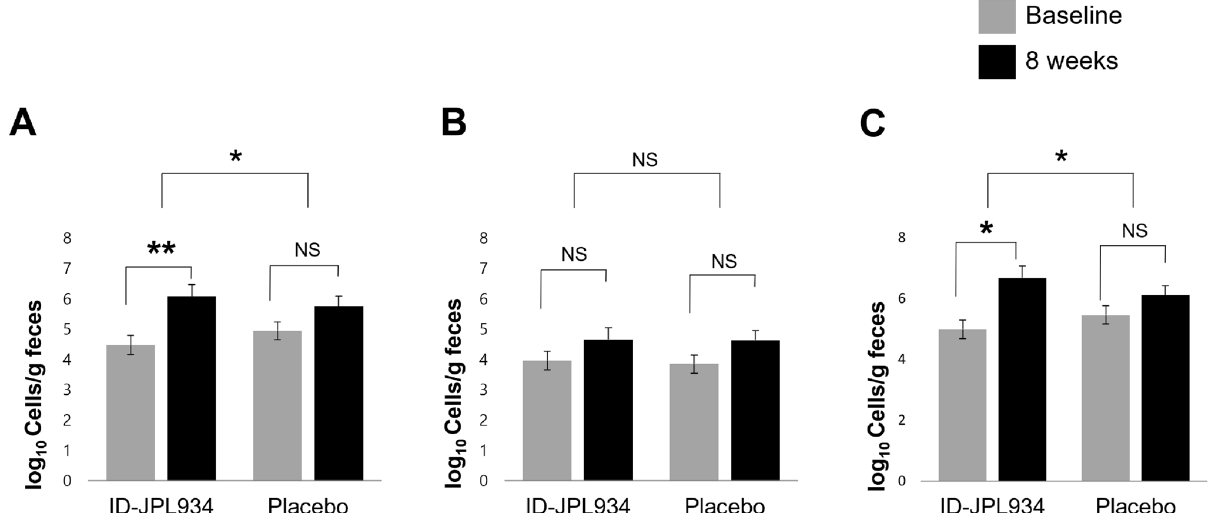
Figure 5. Quantitative changes in fecal probiotic levels at baseline and at week 8. ( A ) Lactobacillus johnsonii IDCC9203, ( B ) Lactobacillus plantarum IDCC3501, ( C ) Bifidobacterium lactis IDCC4301; P -values within the group were calculated using paired t-test; P -values between the 2 groups were calculated using repeated- measures analysis of variance. Means and standardized error are shown. * P < 0.05, ** P < 0.001. NS, not